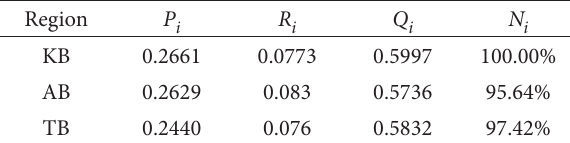
Table 11. Evaluation of utility degree Region